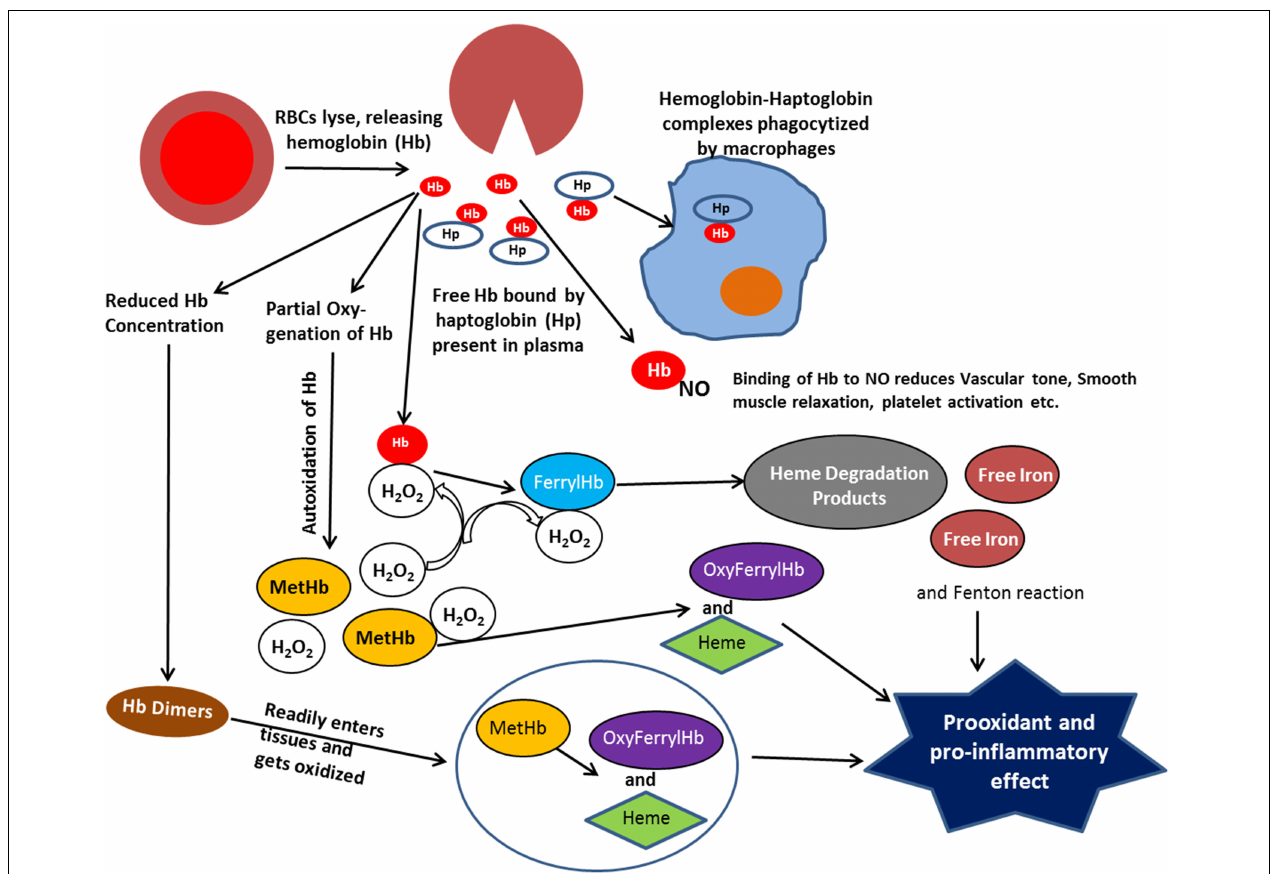
FIGURE 1 | Scheme illustrating the various reactions that take place with extracellular